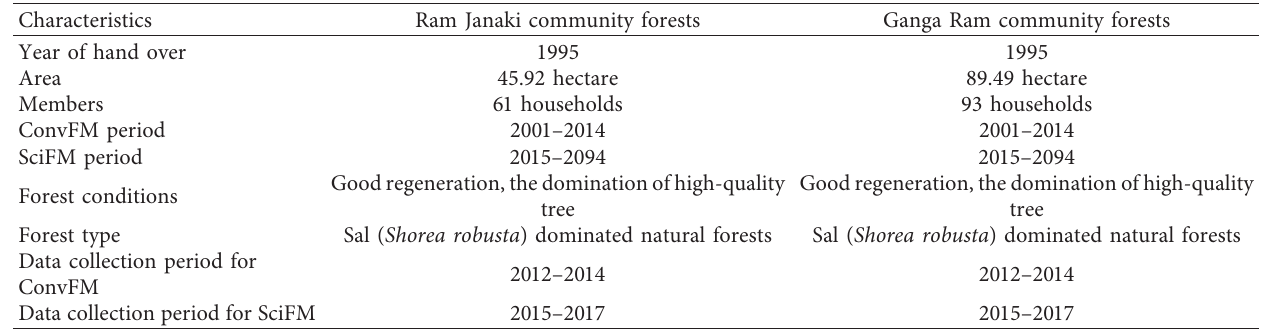
Table 2: Characteristics of the studied community